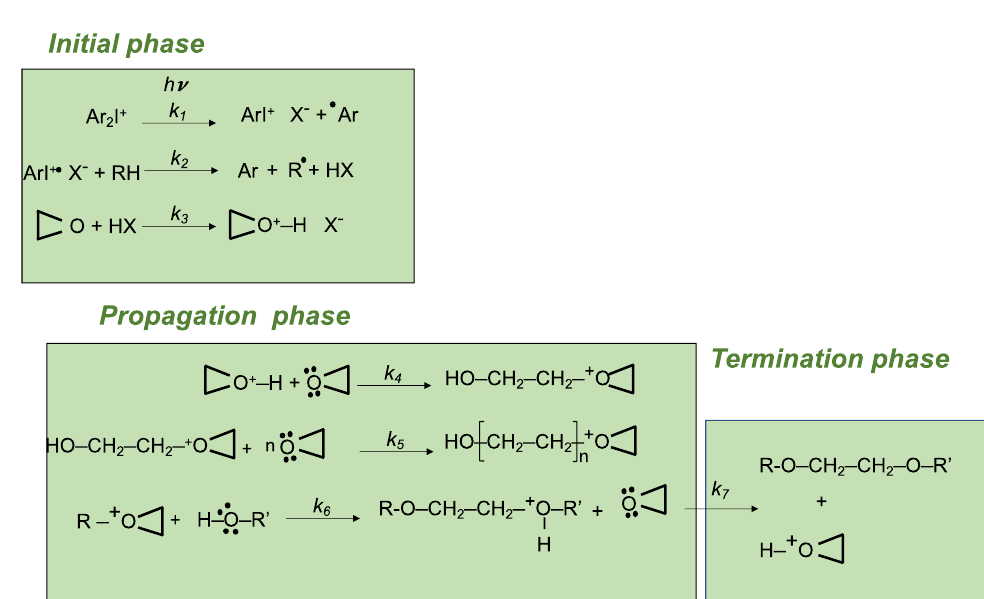
Figure 4. Schematic representation of the cationic polymerization process involving a diaryliodonium salt (Ar-I-Ar) as CPhI (inspired from Crivello et al.) [67] (k is the kinetic rate constant).